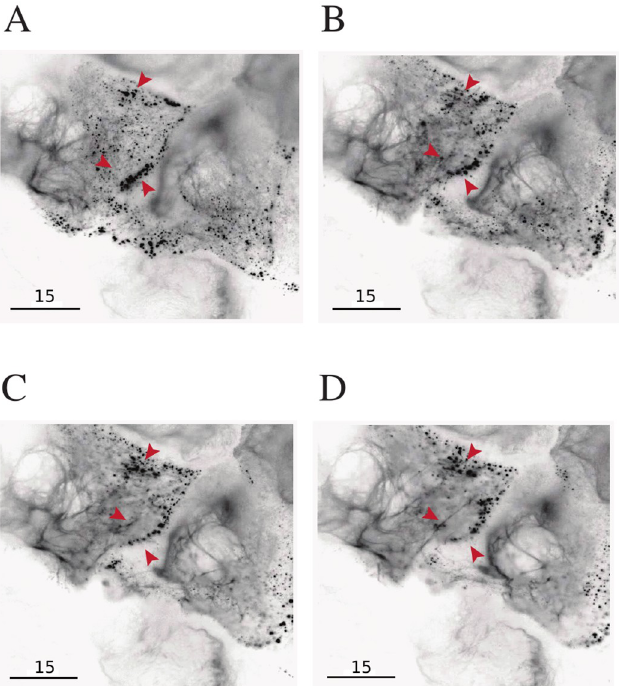
Fig 2. Fluorescently labeled keratin aggregates are dynamic. Steps in EGFP labeled keratin filament’s dynamics. (A) Aggregates, some marked by red arrows, appear at the cell periphery. (B) Aggregates merge and grow in size (arrows). (C) Larger aggregates disappear within minutes of their inward trajectory to the nucleus (arrows). (D) New filaments can be seen in areas where aggregates were visible previously.